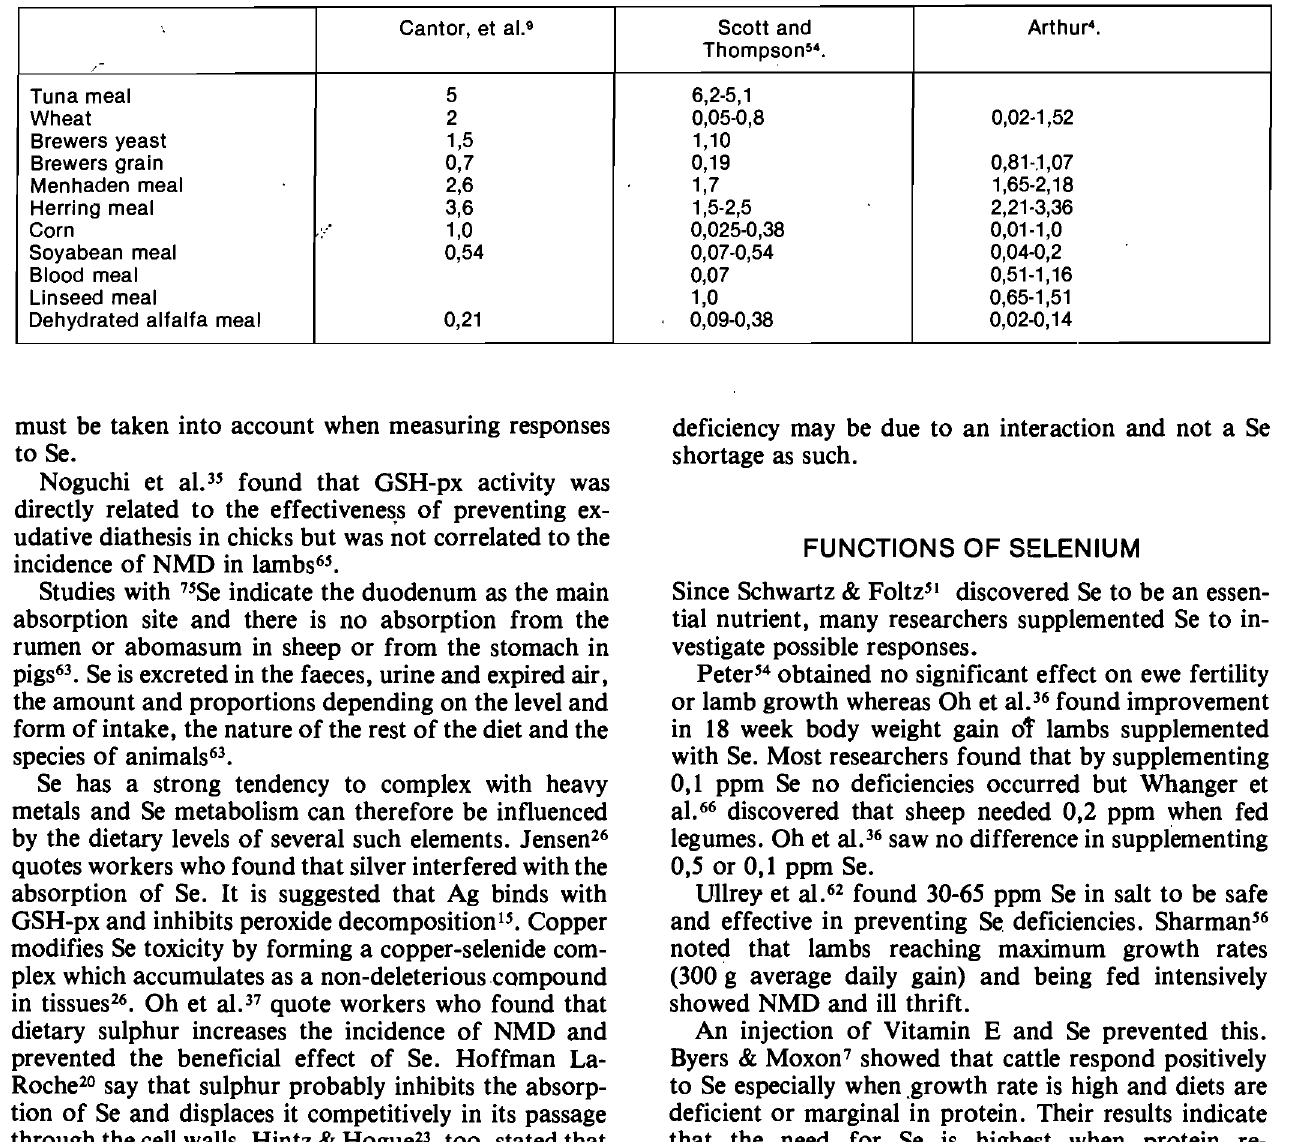
Table 1: Se CONTENT OF A FEW FEED COMPONENTS IN